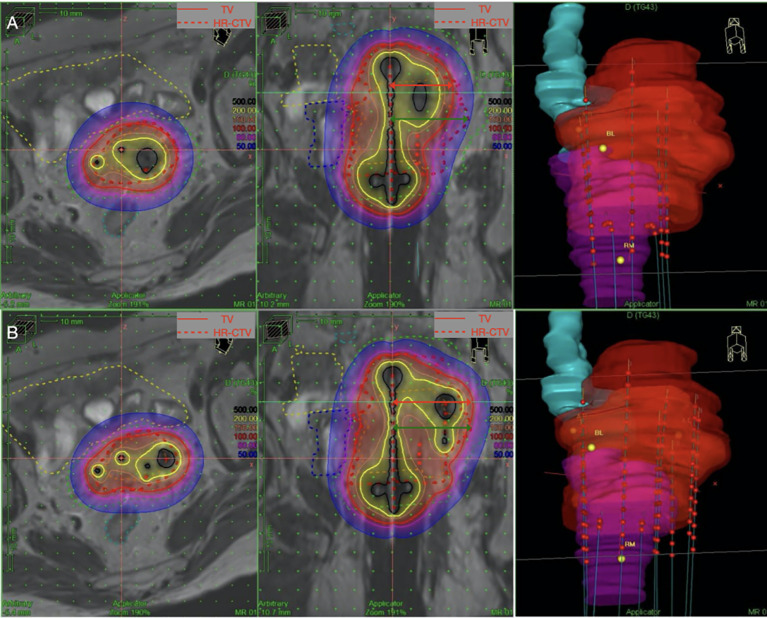
NMD (red arrow) is defined as the maximum distance of the 100% isodose curve from the vertical direction of the uterine tandem at coronal position. Parametrial extension widths (green arrow) is defined as the maximum distance of HR-CTV from the vertical direction of the uterine tandem at coronal position. The parametrial extension widths of this patient is 4.06cm. (A) The standard loading of the IC/ISBT for which free needles were removed shows insufficient coverage of the HR-CTV (D90: 6.06Gy, V100: 83.21%,NMD:3.18cm). (B) Loading of the free needles on the left improves the coverage of the HR-CTV(D90:7.15Gy,V100:91.66%,NMD:4.19cm). CTV, clinical target volume; HR, high risk; D90, the minimum dose delivered to 90% of the target volume. TV, treatment volume, target area covered by the 100% isodose curve.